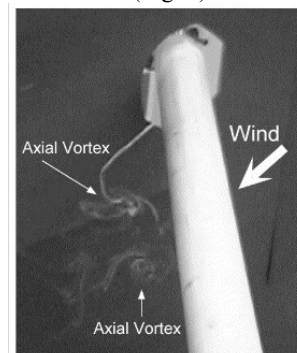
Fig. 5 . Visualised axial vortex in a wake of inclined cable (without end plate,  =45 o , V=0,5 m/s in smooth flow) [6].